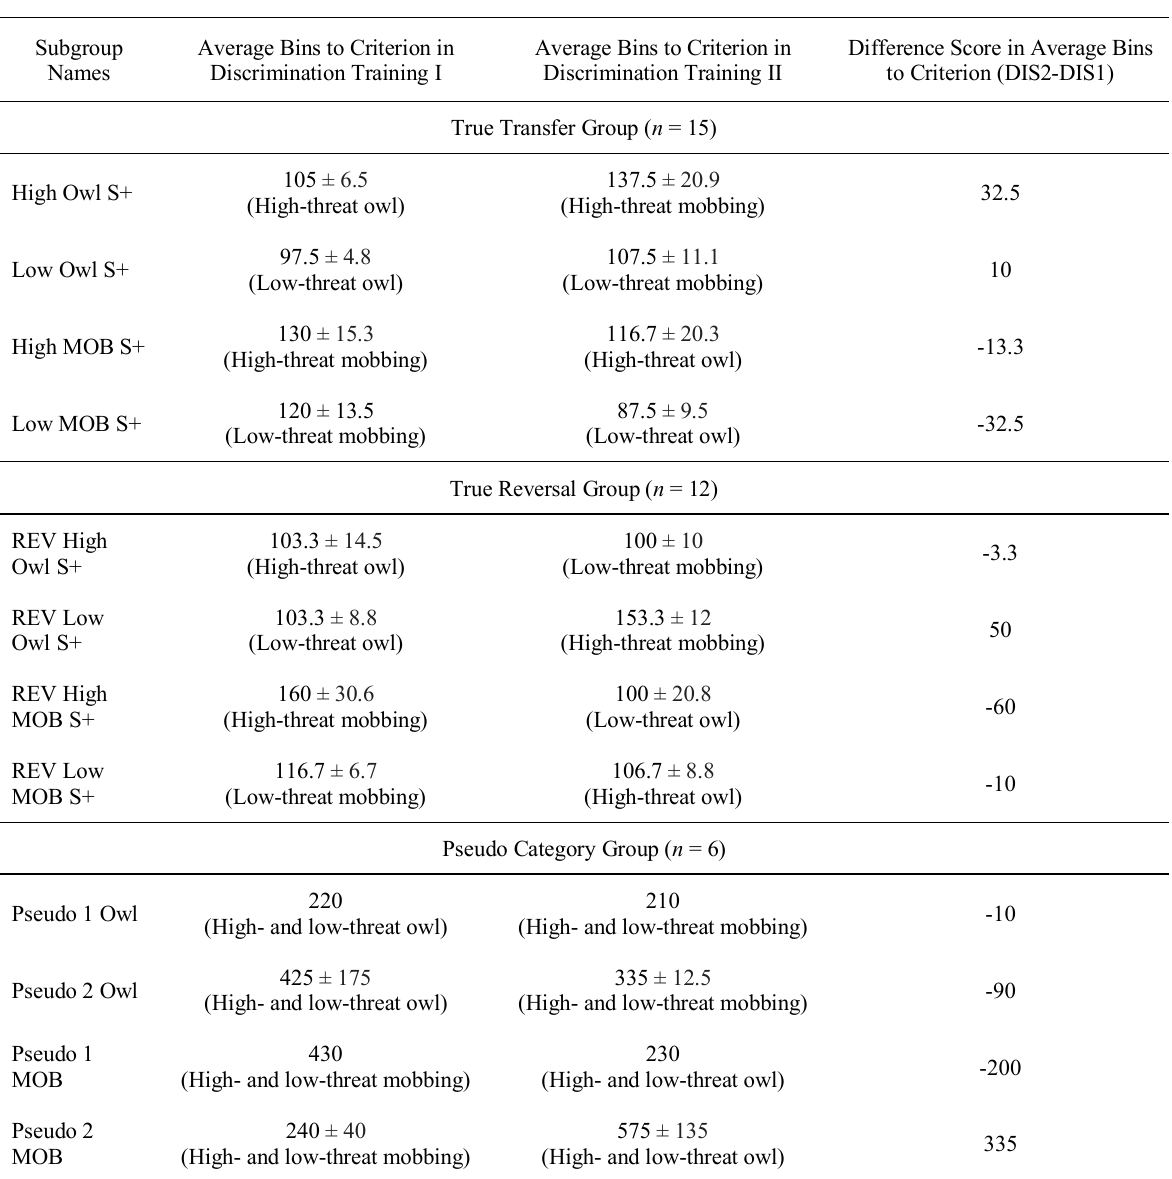
Training and Transfer/Reversal